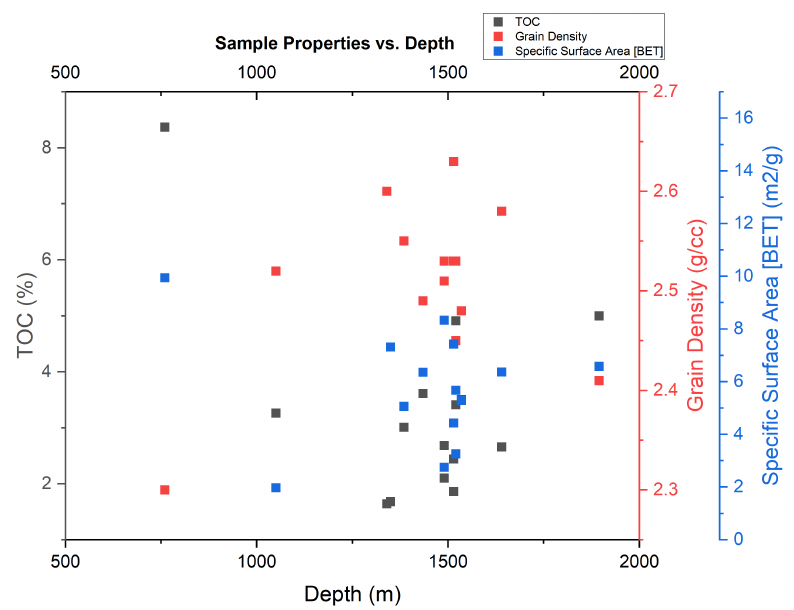
Figure 4. The relationship between petrophysical properties vs. depth (values from Table